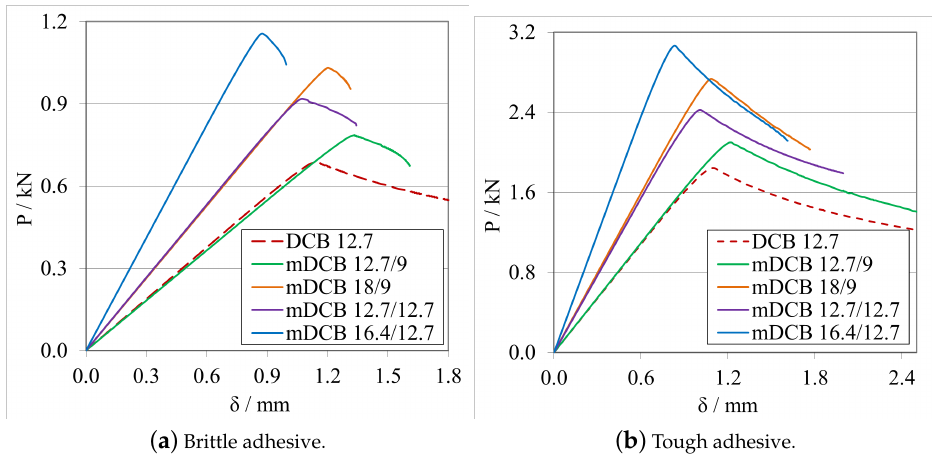
Figure 26. P - δ curves related to several combinations of h ELS and h mDCB , compared against the correspondent standard DCB.